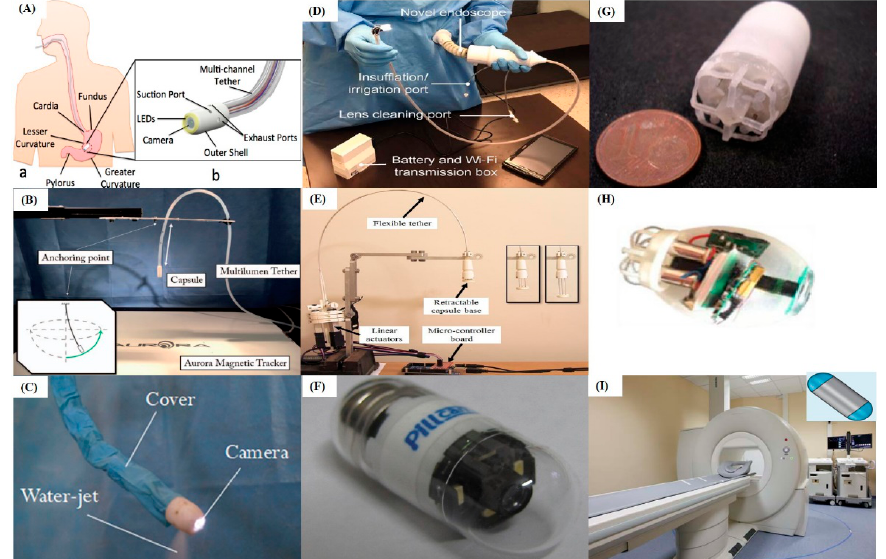
Figure 2. Research (non-commercialized) robotic gastroscopes: HydroJet-like gastroscopes developed by ( A ) Caprara et al. [47], ( B ) Campisano et al. [48], and ( C ) Yin et al. [49]; ( D ) Pneumatic gastroscope developed by Garbin et al . [50]; ( E ) Cable driven gastroscope developed by Ye et al. [51];